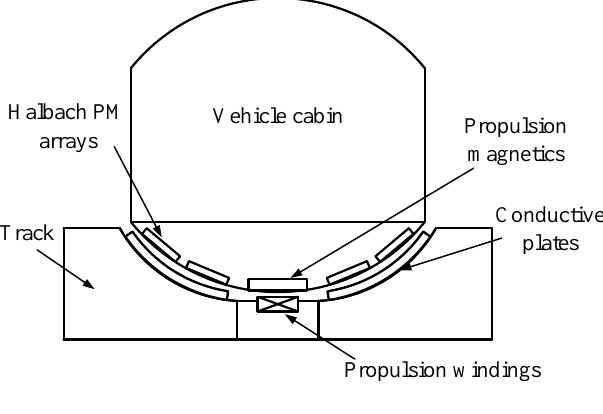
Figure 1. Structure of Magplane.